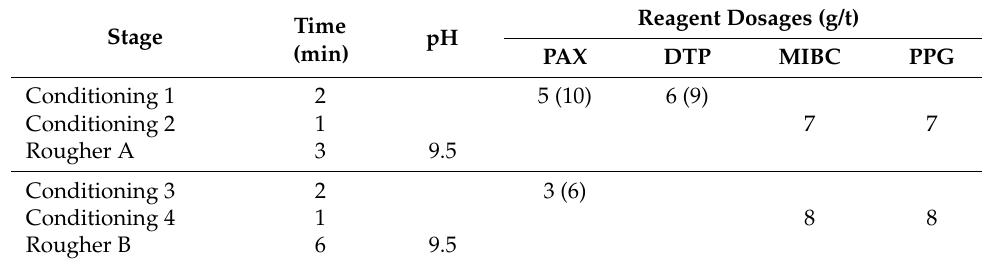
Table 3. Rougher flotation conditions (baseline values, with higher collector dosage in brackets).